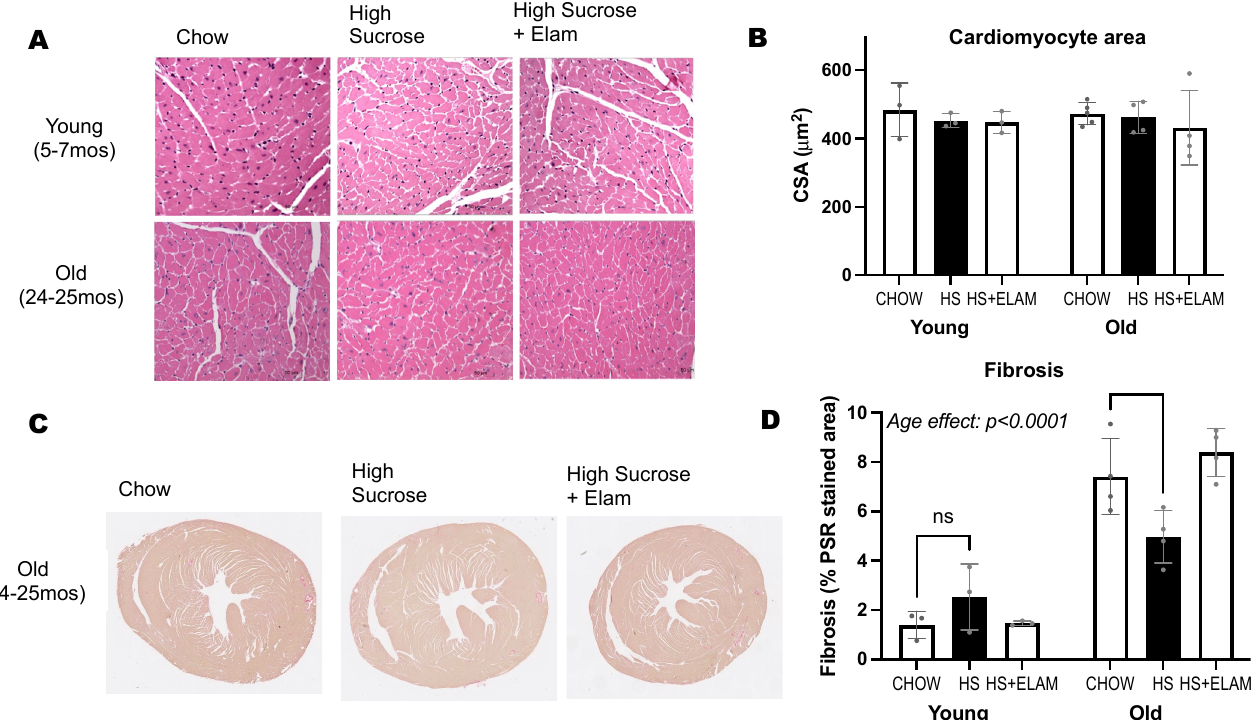
Figure 6. Histological analysis of heart tissue. Sections of heart apex stained with H&E ( A ) and Picrosirius Red ( C ) to measure cardiomyocyte size ( B ) and collagen content ( D ). Significant differences between old and young are indicated by age effect p < 0.05. Differenced between old–chow and old–HS are indicated with a smaller bracket containing the p –value or asterisk if <0.05. Data expressed as mean ± SD.